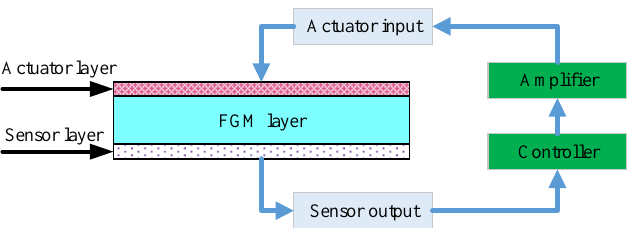
Figure 3. Diagram of the active control of the functionally graded plate (FGP) with surface-bonded a piezoelectric actuator and sensor.